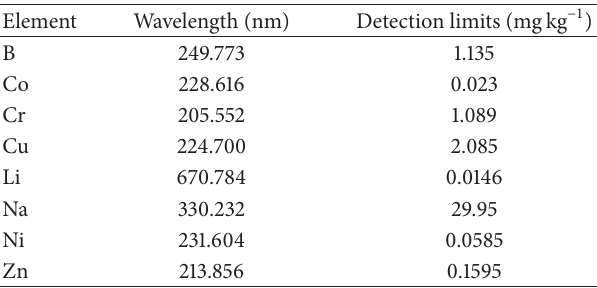
Table 3: Wavelength and the detection limit for elemental analysis.